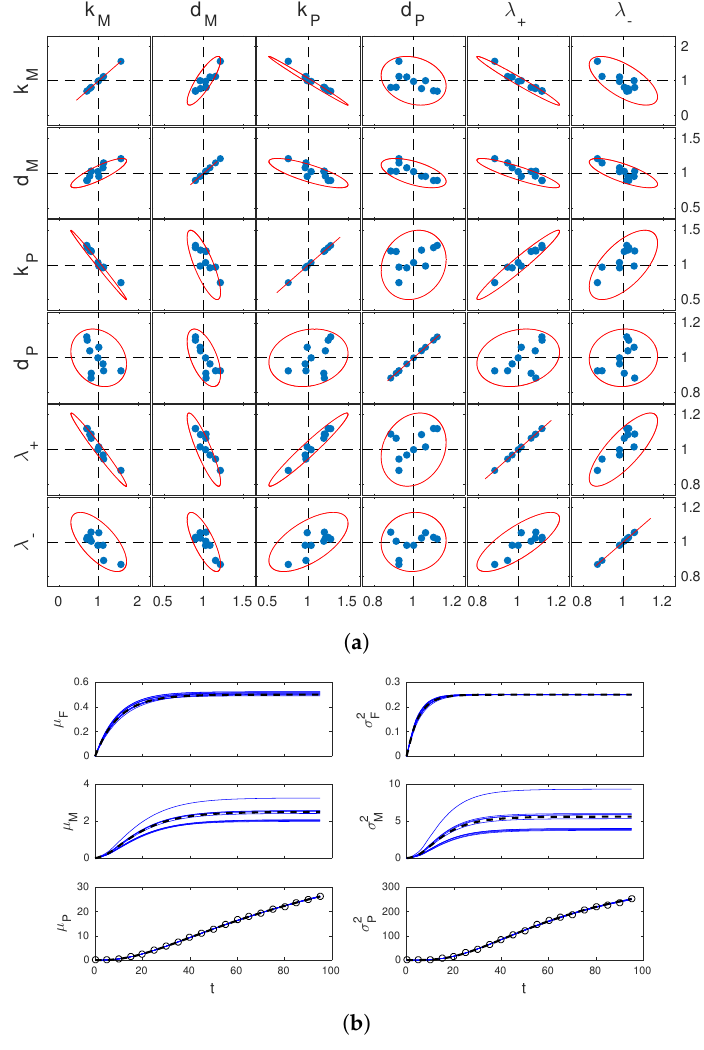
Figure 2. Parameter estimation results. ( a ) scatter plots of the estimates of parameters ( k ) from 10 simulated datasets (blue dots) and theoretically computed 95% M , d M , k P , d P , λ + , λ − confidence regions (red lines). Results for all different pairs of these parameters are reported in the different boxes, as per labeling on top and left of the figure. Estimated values and pairwise confidence ellipsoids (one-dimensional confidence intervals for boxes on the diagonal) are normalized by the true parameter values. Dashed lines show the reference coordinates ( 1,1 ) corresponding to true values; ( b ) estimated dynamics of the system means (left) and variances (right), corresponding to the 10 different estimates of θ ∗ in (a). Solid blue lines show estimates, dashed black lines show true system statistics. In the bottom plots, black circles show measurements used for one of these